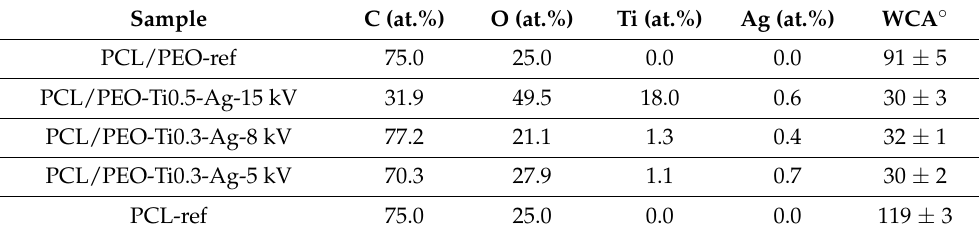
Table 1. Composition of samples (in at. %) derived from XPS analysis and the WCA their surfaces.